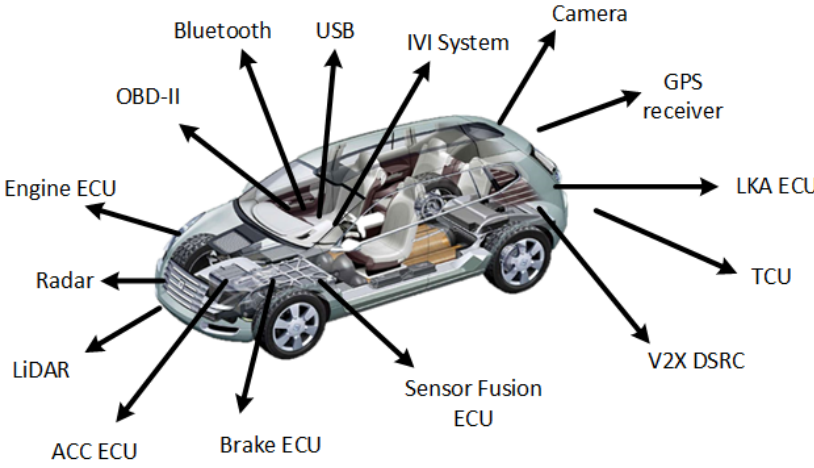
Figure 2. Smart Autonomous Vehicular System